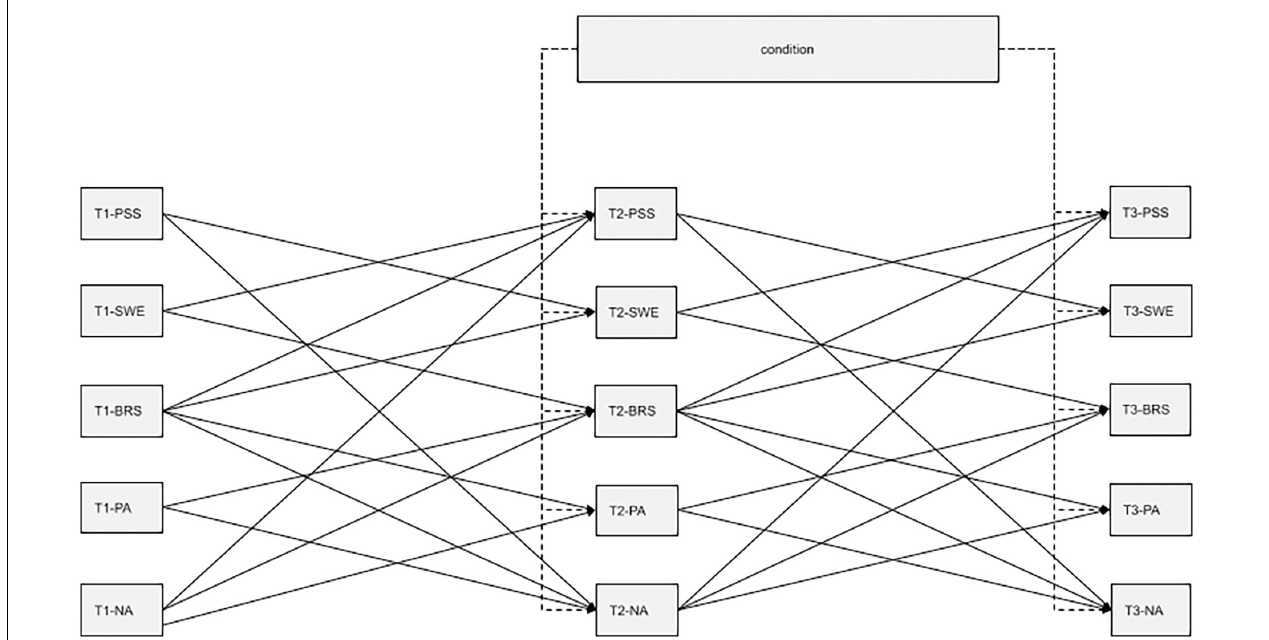
FIGURE 2 | Conceptual – cross-lagged effects model over all measurement